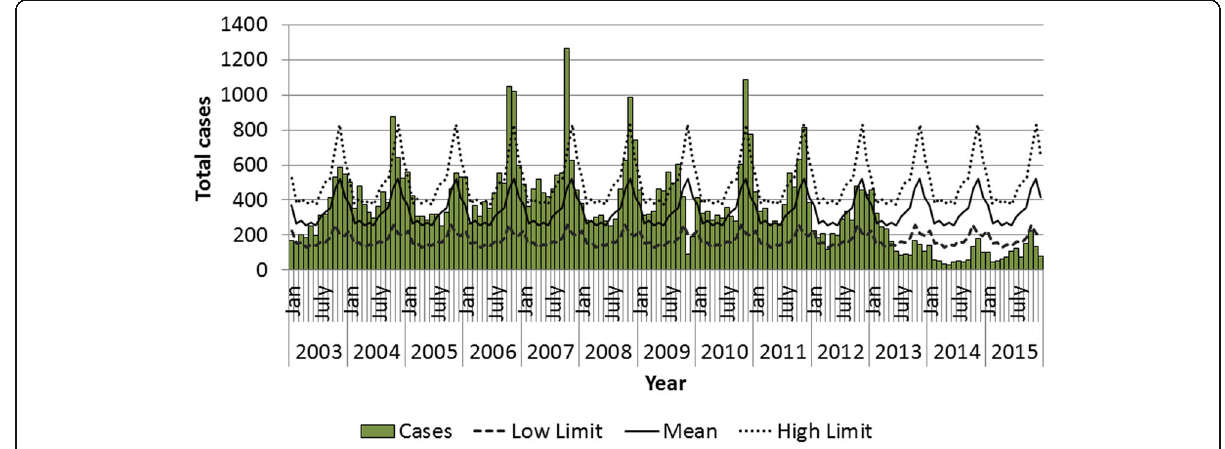
Fig. 2 Endemic curve of malaria cases in the municipality of Oiapoque between 2003 and 2015. Source: Sivep-Malaria